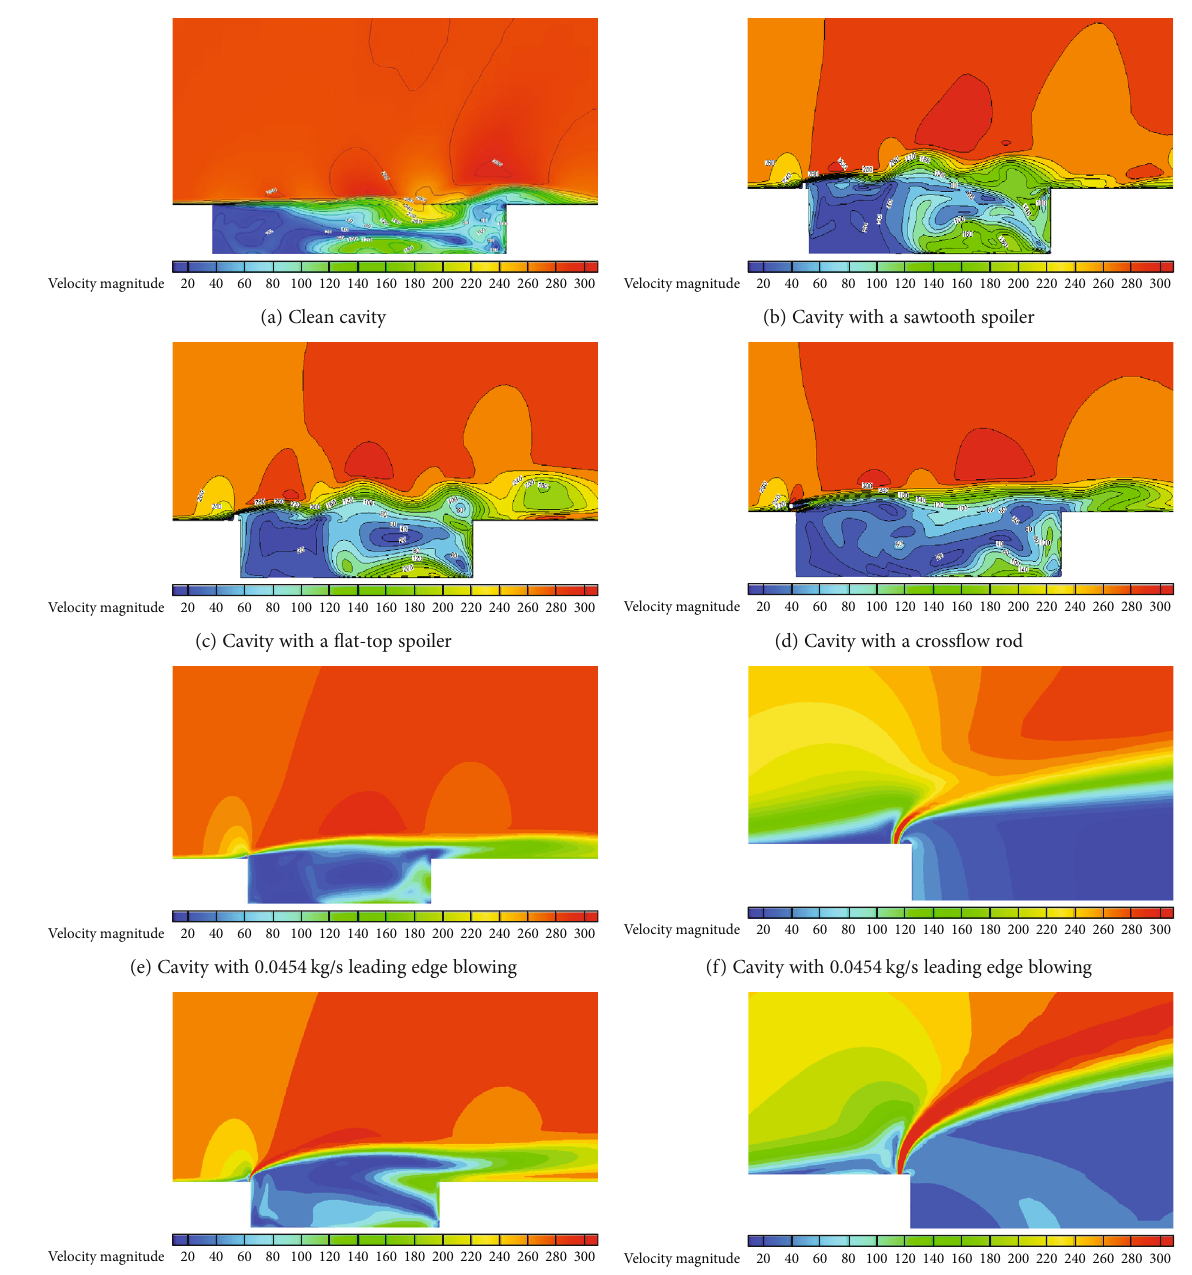
Figure 8: Pro fi le of instantaneous